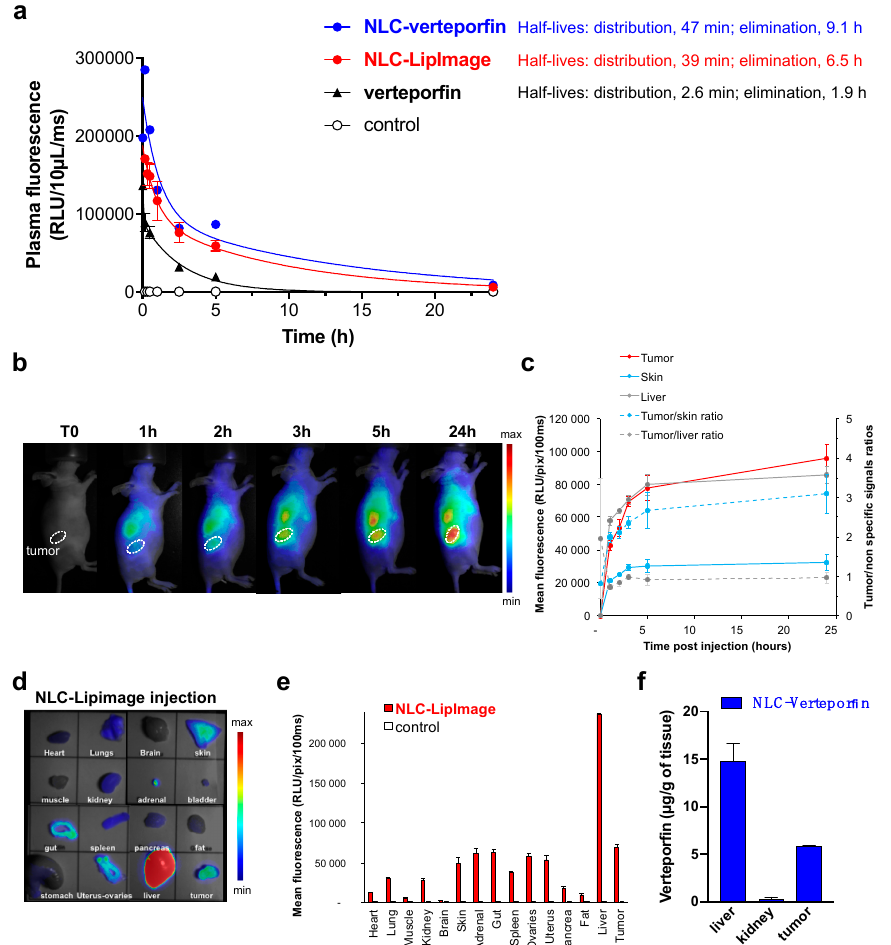
Figure 4. NLC circulated in the bloodstream and accumulated in subcutaneous SKOV3 tumors. ( a ) Healthy mice were injected intravenously with NLC-verteporfin (8 mg · kg − 1 of verteporfin), dye-loaded NLC (LipImage TM -815), or free verteporfin (2 mg · kg − 1 ). Fluorescence intensity measurements of verteporfin (for free verteporfin or NLC-verteporfin), or of LipImage TM -815 (for NLC-LipImage) were performed on blood plasma samples taken at di ff erent time points. The results are expressed as the mean ± SD ( n = 3). ( b – e ) Mice with SKOV3 subcutaneous tumors were injected intravenously with NLC-LipImage. ( b ) Representative fluorescence images (50 ms integration time) recorded using 2D-Fluorescence reflectance optical imaging (FRI) at di ff erent times after intravenous injection are shown (min-max: 4243-55869). Dotted lines show subcutaneous tumors. ( c ) Regions of interest (ROI) are defined on tumor, liver, and skin to semi-quantify the amount of photons detected per pixel. The results are expressed as the mean fluorescence ± SD in tumor, skin, and liver, and as the mean tumor / skin and tumor / liver fluorescence ratios ± SD ( n = 3). ( d ) Fluorescence images